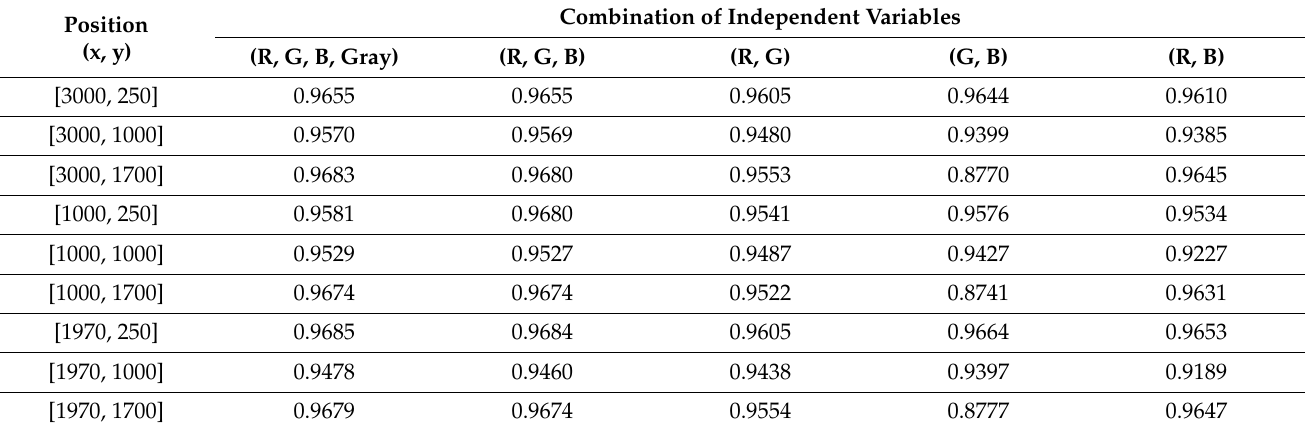
Table 1. Adjusted R-squared values of the developed